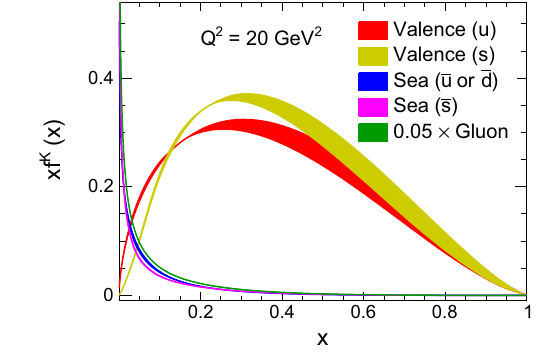
Fig. 8 The valence quark, sea quark and gluon distributions of the kaon from this work, in the range of large x . The error bands show the 3 σ uncertainties of the quantities